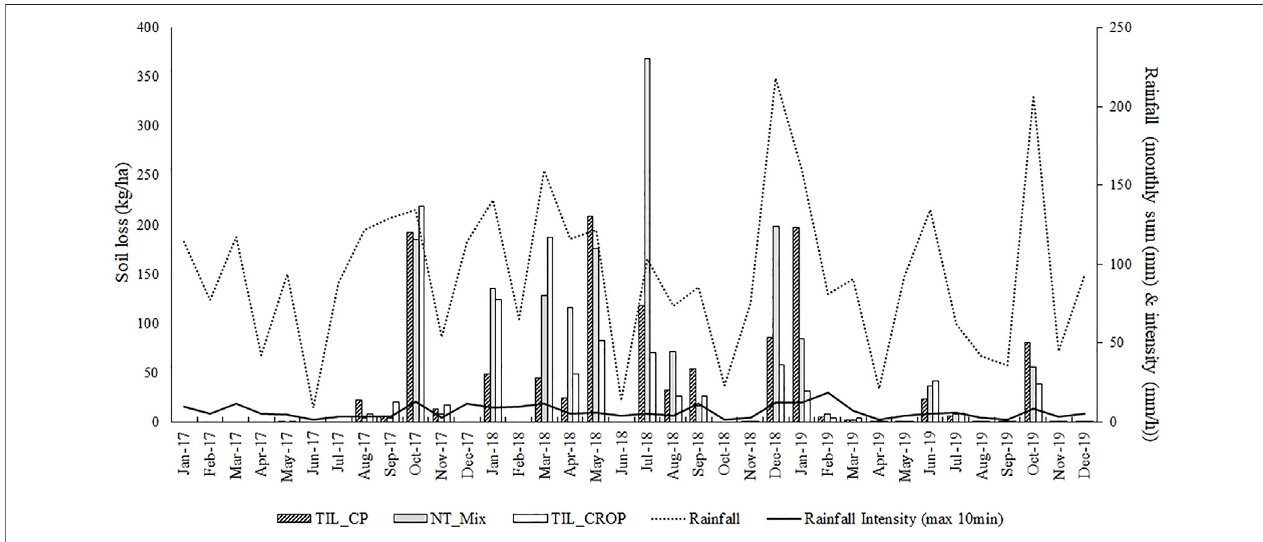
FIGURE5 | Monthly pattern ofsoil erosion for therespective treatment groups inrelation toclimatic variables ofmonthly rainfall and highest monthly10-min rainfall intensity.